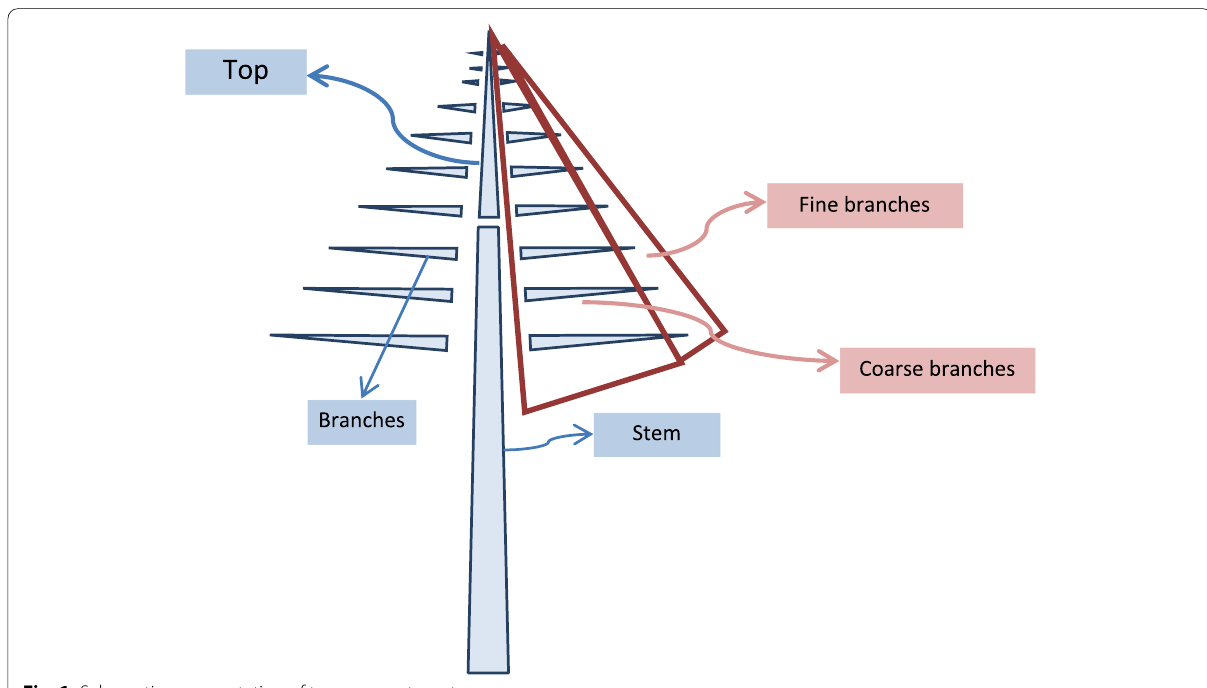
Fig. 1 Schematic representation of tree